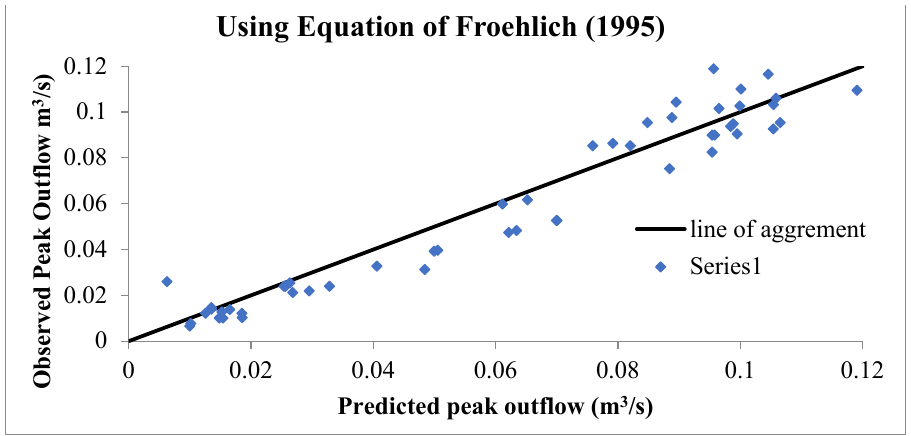
Figure 13. Variation of observed peak outflow with predicted peak outflow using Froehlich [16,17] Equation